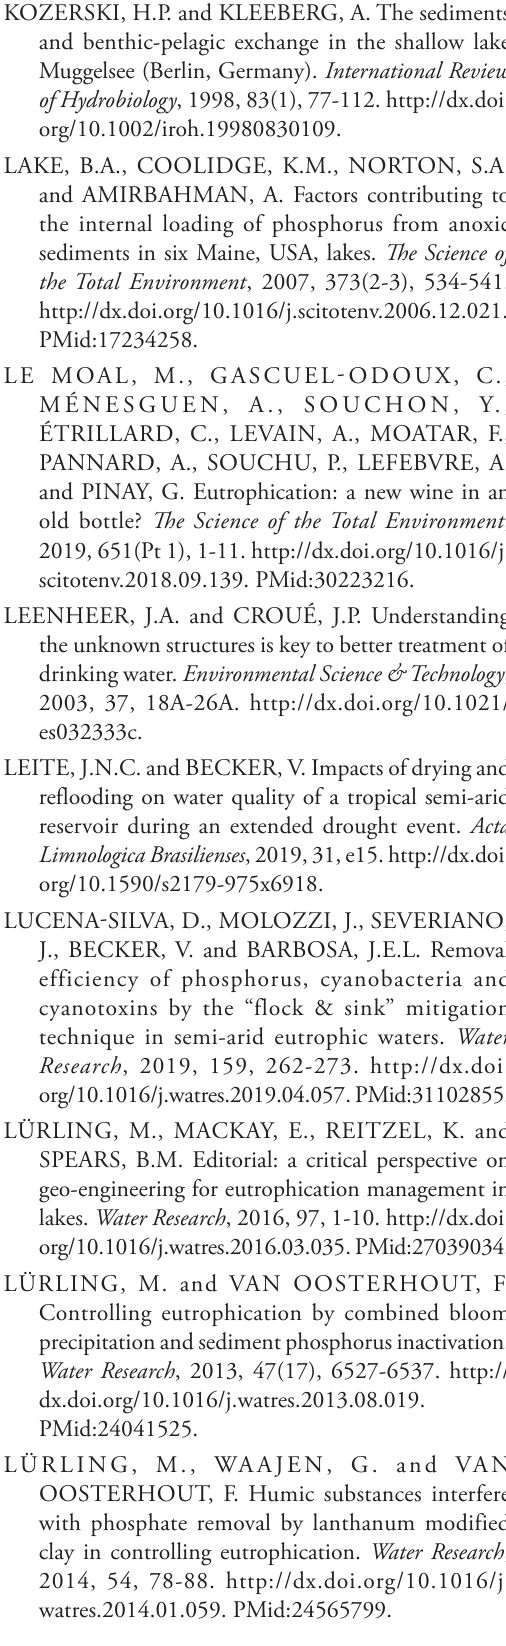
FIGUEIREDO, A.V. and BECKER, V. Influence